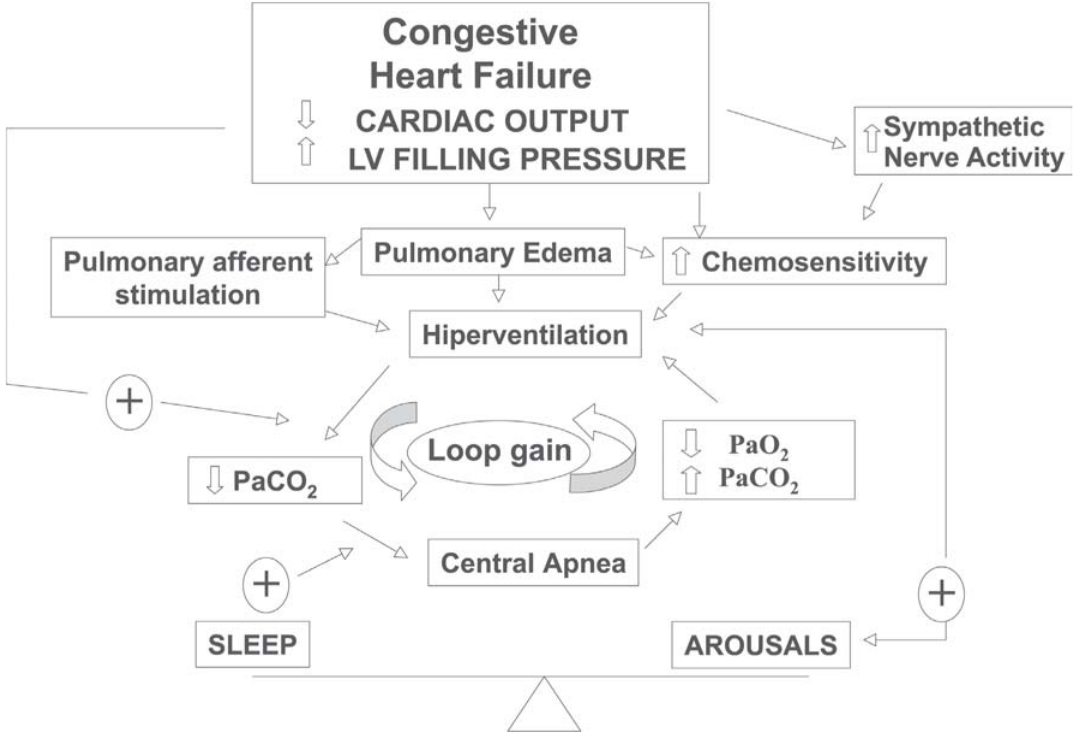
Figure 2 - Schematic representation of the mechanisms involved in the genesis of Cheyne-Stokes